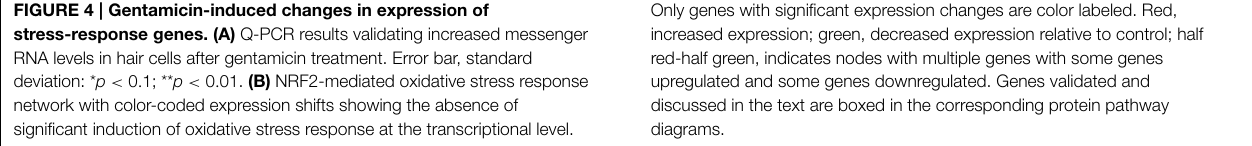
NF- κ B targets are summarized in Table S3 . Our expression data indicate that the NF- κ B pathway, like the JNK pathway, is an early response pathway that is activated in hair cells by